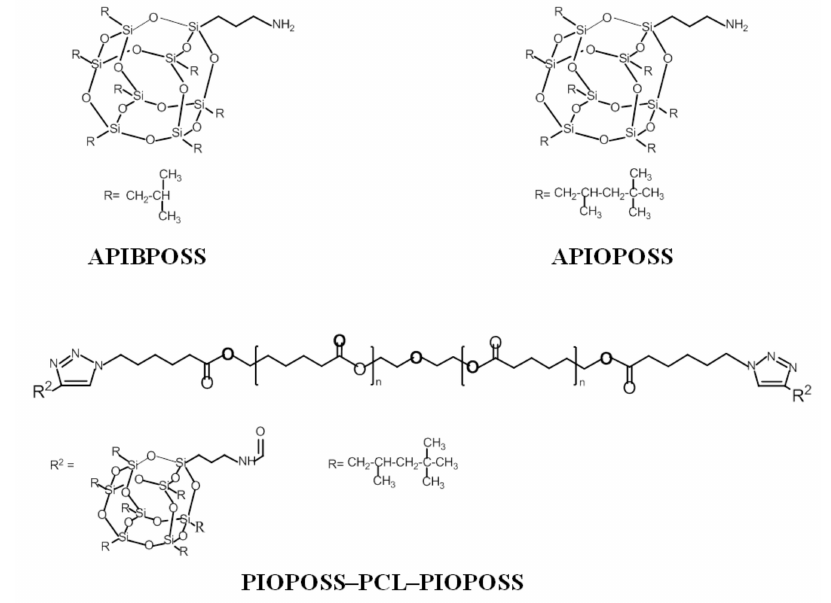
Figure 1. The chemical structure of polyhedral oligomeric silsesquioxanes (POSS) types used in this